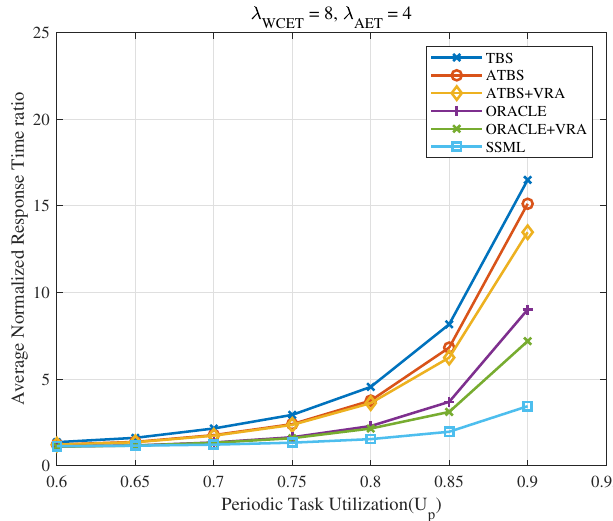
Figure 4. Comparison of average normalized response time ratio according to different periodic task utilization when the exponential distribution average of worst-case execution time (WCET) and actual execution times are 8 and 4, respectively.